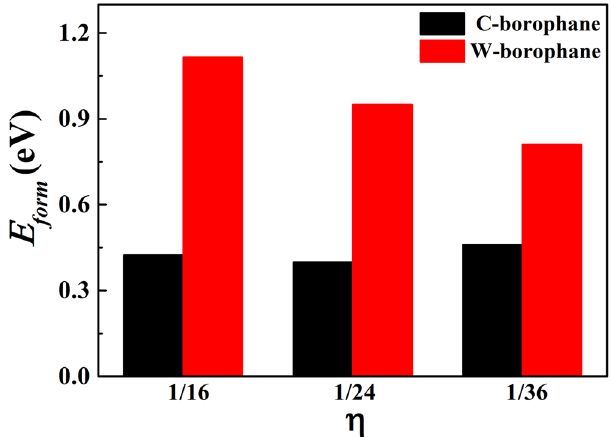
Figure 10. Defect formation energy of a B-H dimer in C- and W-borophane. One B-H dimer defect has been introduced into the supercell, hence, defect concentration η can be expressed as η = 1/ N number of B atoms in the perfect